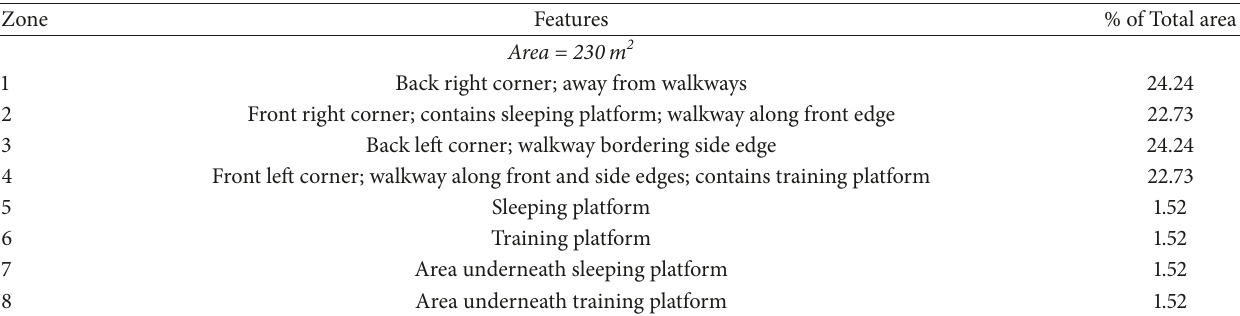
Table 12: Zone descriptions of Whipsnade